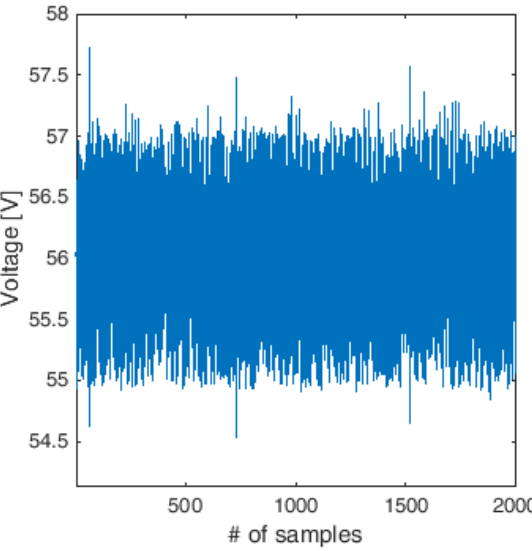
Figure 13. Output voltage profile of the battery pack during the dumpster lift operation.